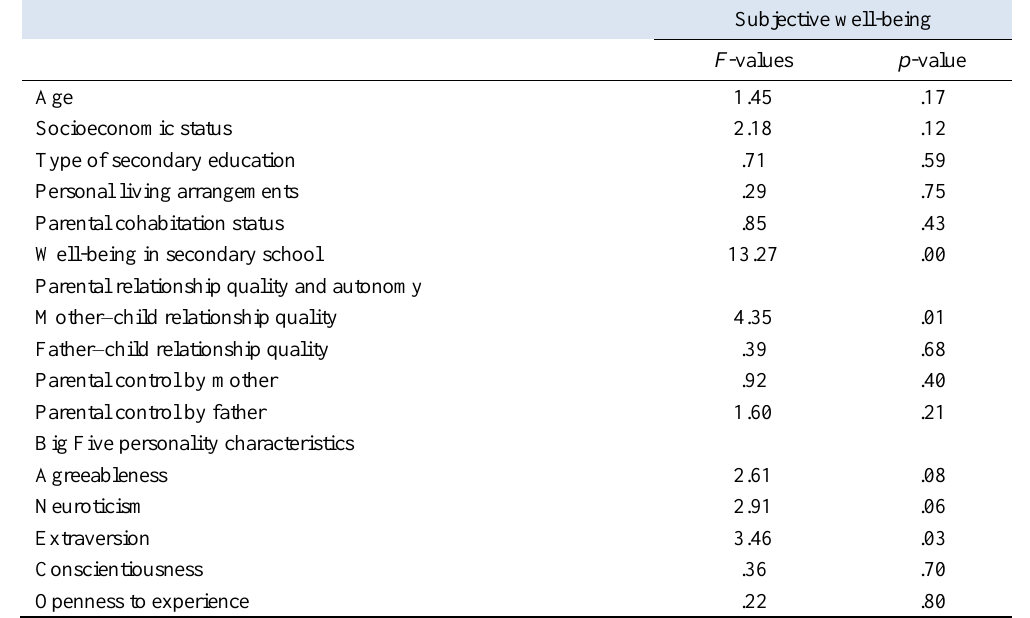
Multivariate analysis of variance with students’ subjective well-being as dependent variable and selected independent